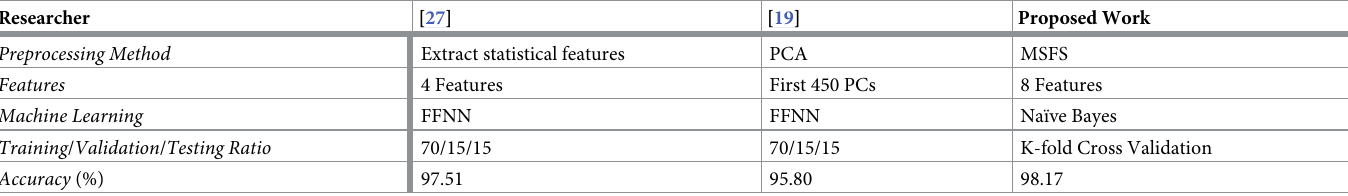
Table 8. Comparison with previous researches (Data from these researches were fed into the proposed method in this paper).